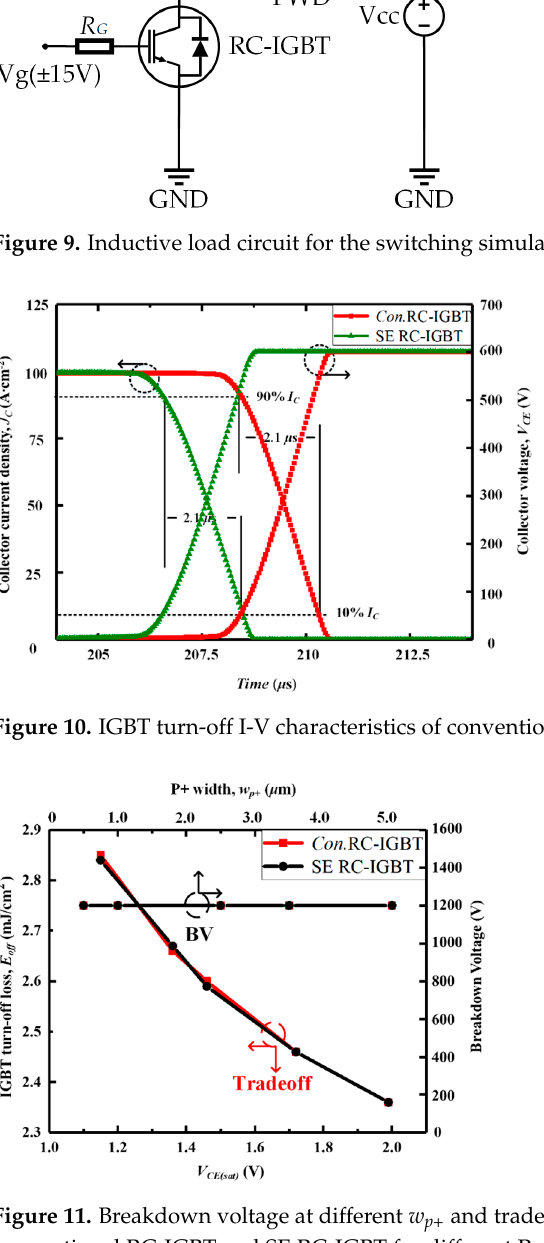
Figure 9. Inductive load circuit for the switching simulation of RC-IGBT.